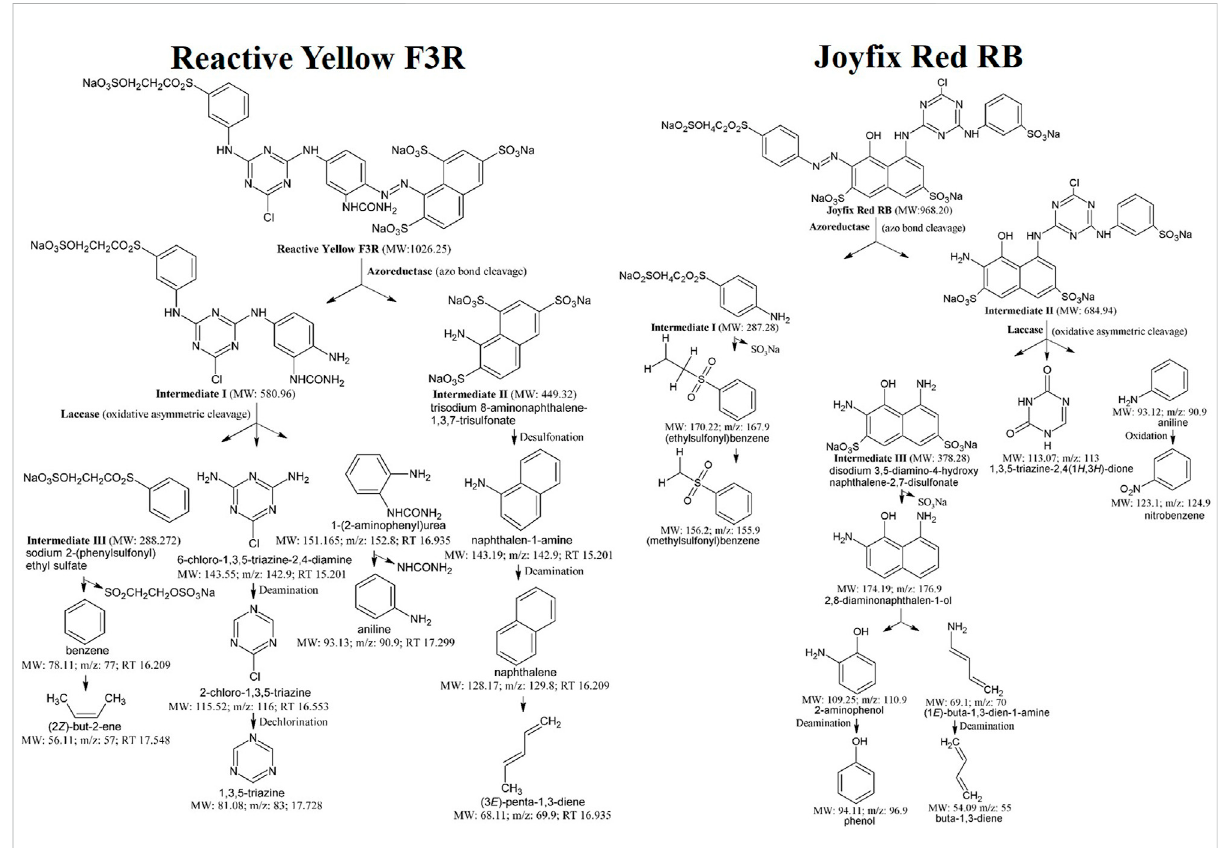
FIGURE 4 Proposed pathways for degradation of Reactive Yellow F3R, Joy fi x Red RB dyes by L. sphaericus MTCC